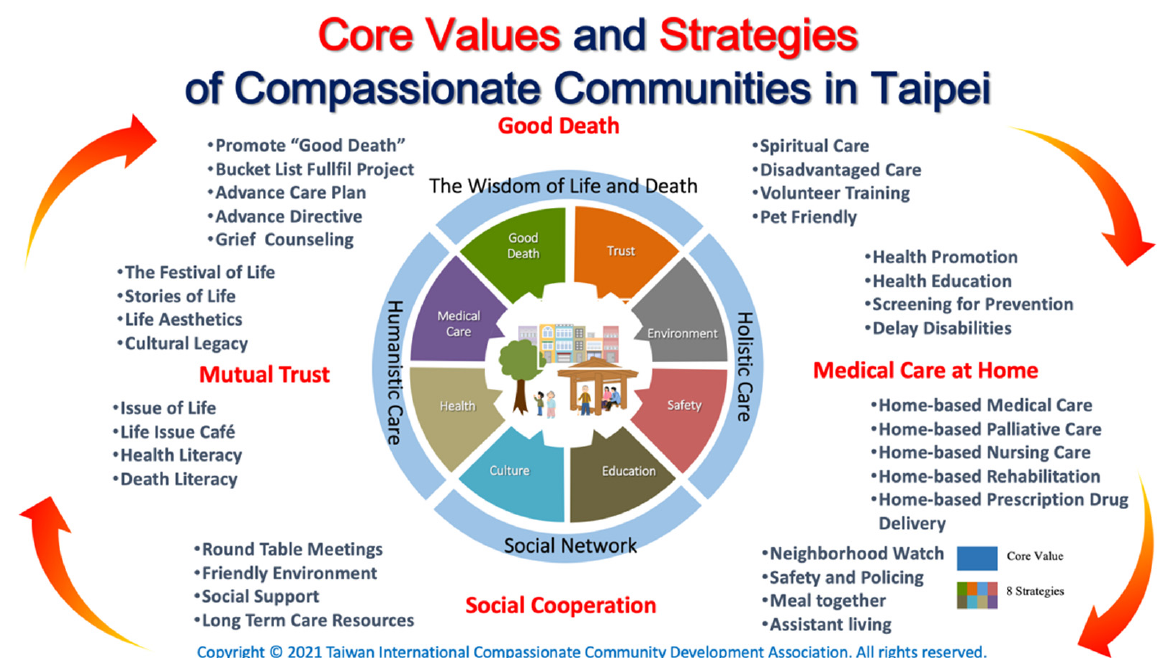
Figure 1. Core values and strategies of compassionate communities in Taipei.